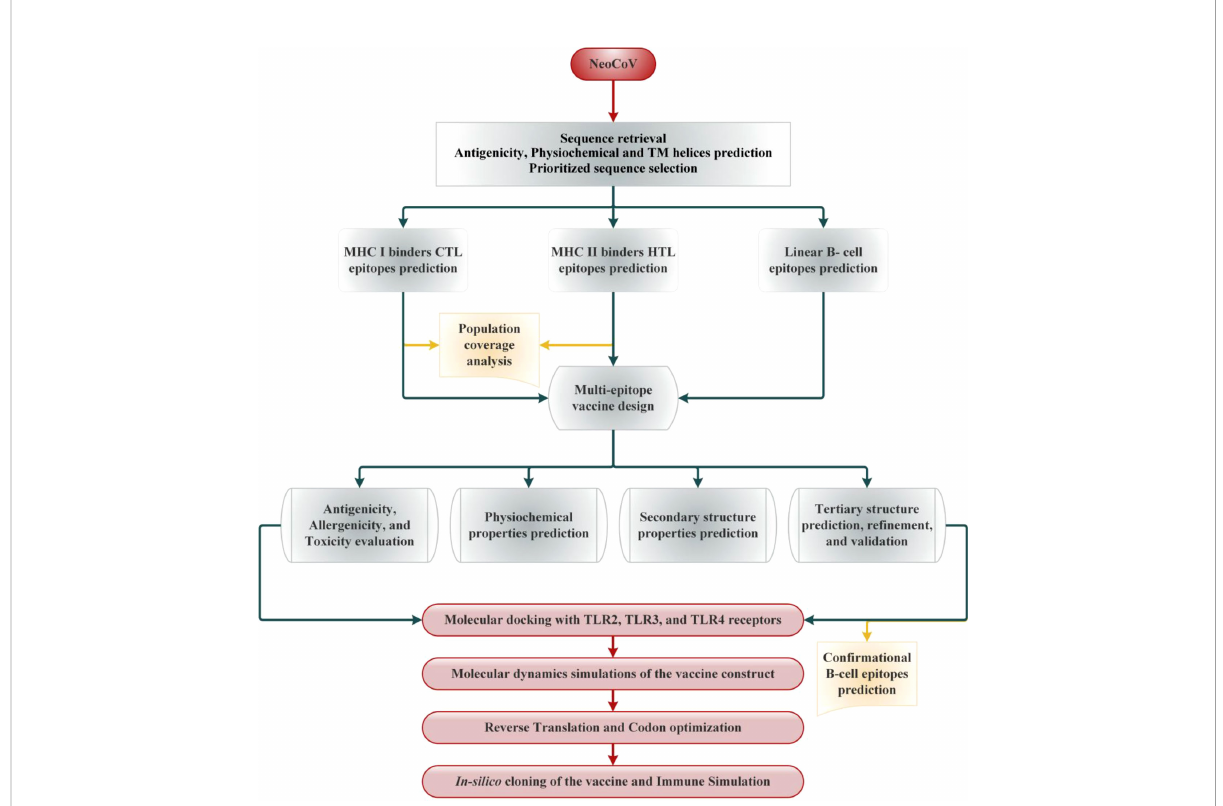
FIGURE 1 Schematic illustration of the overall strategy implemented in this study to design multi-epitope-based vaccine from NeoCoV whole